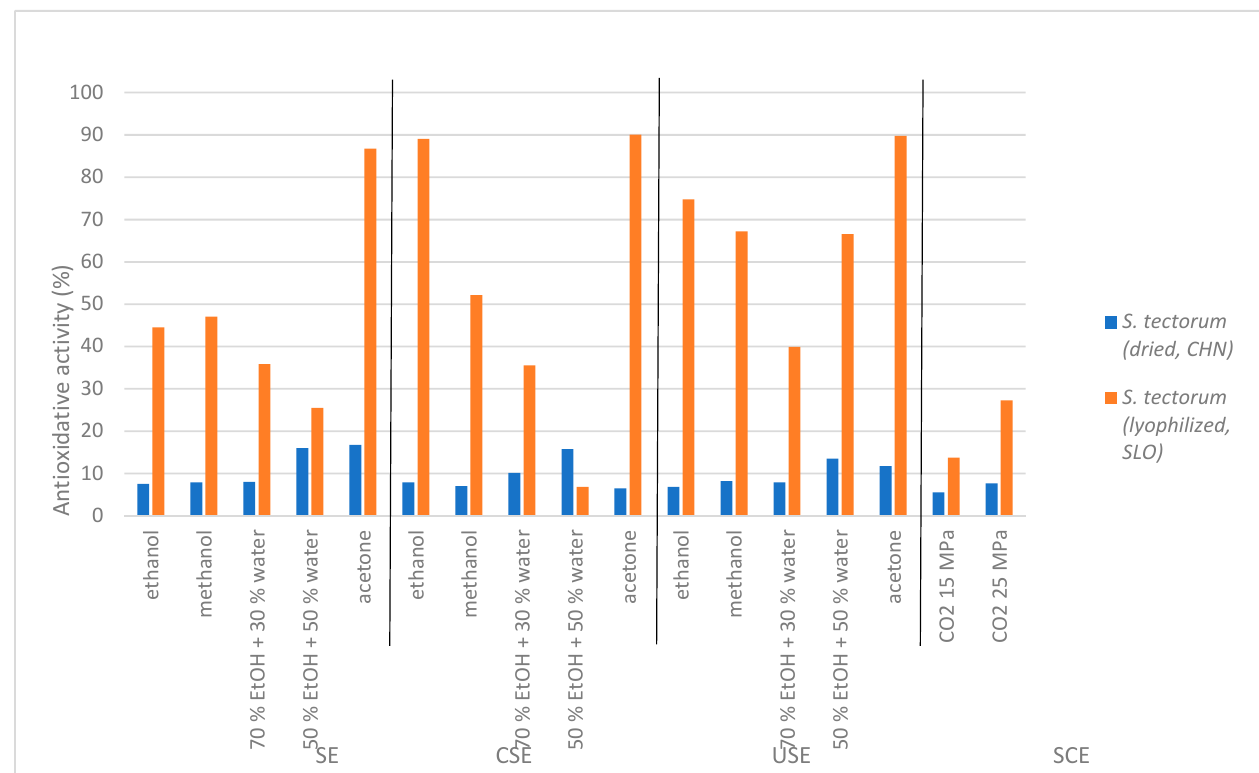
Figure 3. Antioxidative activity of S. tectorum extracts (SE, Soxhlet extraction; CSE, cold solvent extraction; USE, ultrasound extraction; SCE, supercritical extraction).